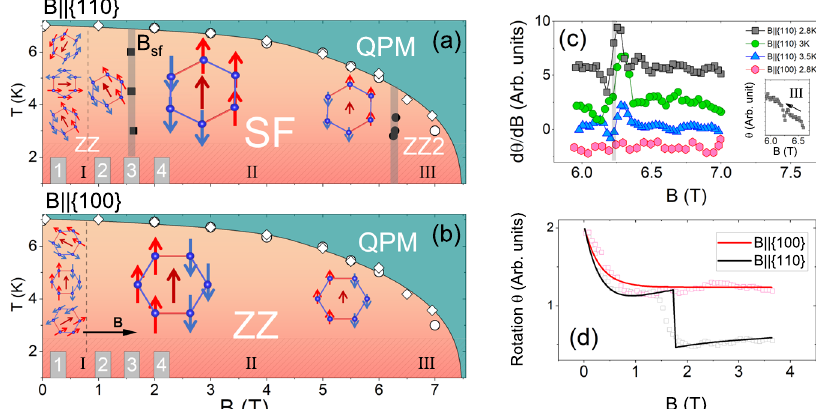
Fig. 6 Low- fi eld and high- fi eld anomalies in the magneto-optical response of α -RuCl 3 . a , b Schematic sketch of the temperature- fi eld phase diagram of α -RuCl 3 for two directions, {1, 1, 0} ( B ab perpendicular to the Ru – Ru bond) and {1, 0, 0} ( B ab along the bond). The three different observed regimes I (ZZ), II (SF), and III (ZZ2) are displayed. In regime I, three initial domains are present. More details on each step (1 – 4) can be found in the main text. After step 2, the most populated domain is depicted for each fi eld direction. For the fi elds larger than B sf , the similar spin orientation is shown. Black square and circle symbols are derived from MLD experiments and show the metamagnetic transition fi elds for different temperatures. White square and circle symbols show the boundary with QPM phase obtained by MLD and MLB experiments, respectively. c High- fi eld anomalies of d θ /d B at different temperatures. The inset shows the jump in the MLD data at 6.2 T. d The proposed model simulates domain population and the spin- fl op